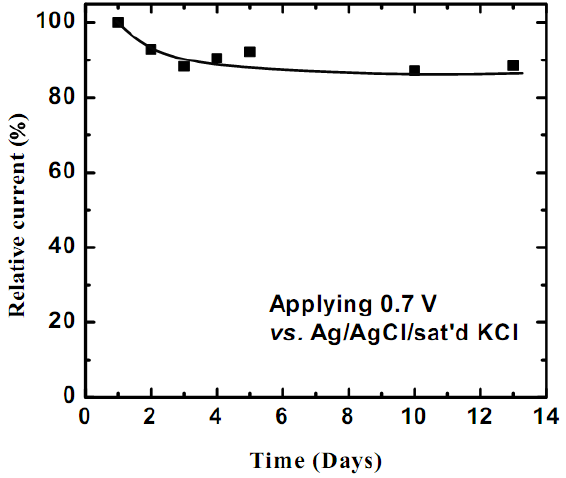
Figure 8. The long-term stability of the cholesterol biosensor at a sensing potential of 0.70 V vs. Ag/AgCl/sat’d KCl.